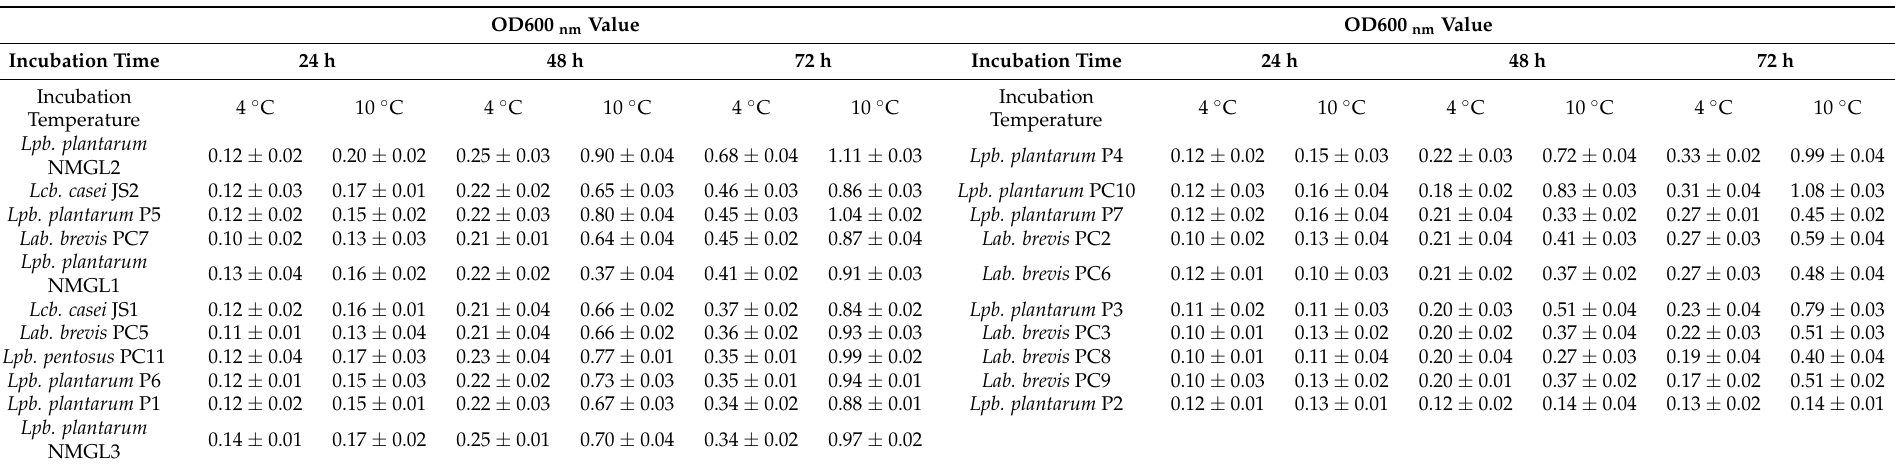
Table 1. Growth of 21 strains of lactic acid bacteria at 10 ◦ C and 4 ◦ C for 72 h ( n = 3, x ± SD).